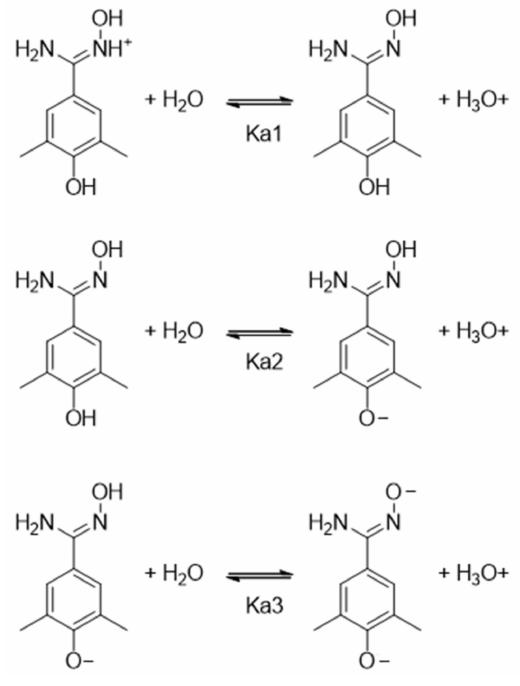
Figure 6. Acid-base equilibria of VIS310 ( 9